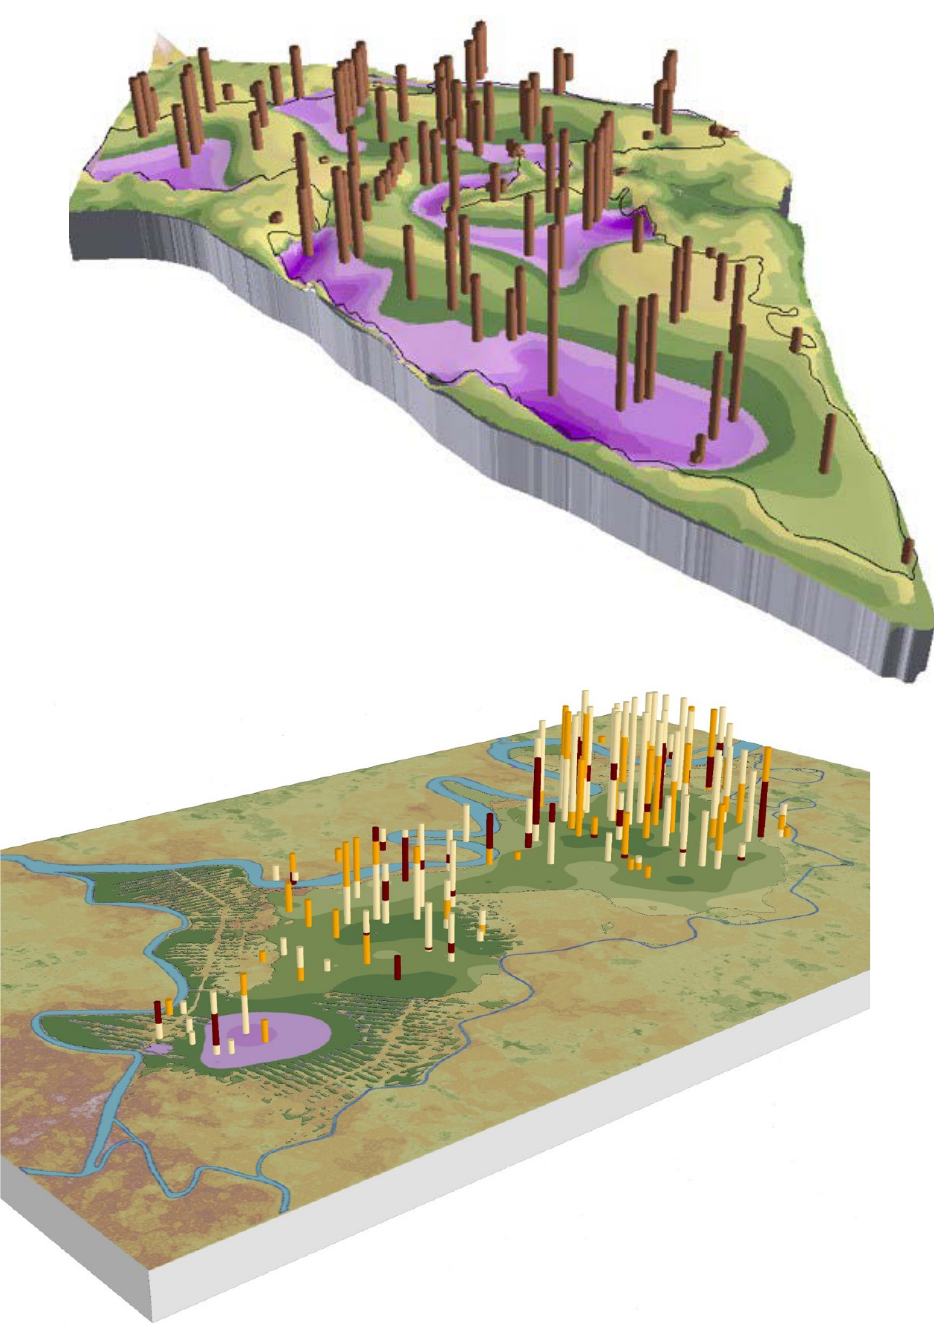
Figure 5. 3D Visualisations of peat base elevation (see Figure 4 for legend) at Bengkalis (above), with measured peat thickness in soil cores and at Kubu Raya (below), with measured thickness of individual saprist, hemist or fibrist peat soil strata observed in core